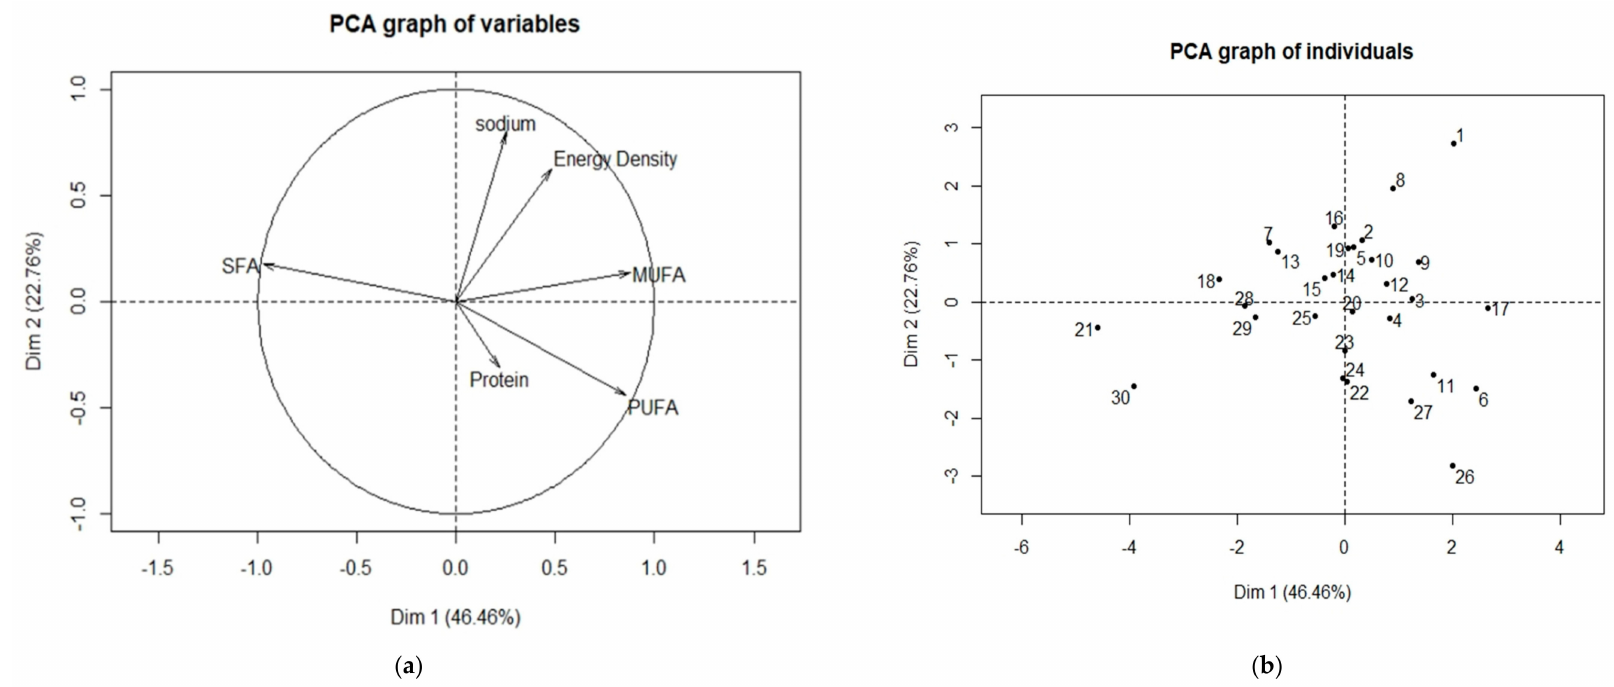
Figure 2. ( a ) PCA plot of di ff erent variables; ( b ) PCA plot of individual sample. (1) Salted Egg Fish Skin; (2) Arrowhead Cracker; (3) Peanut Pu ff ; (4) Egg Crisp; (5) Plait Cookies; (6) Peanut Candy; (7) Cashew Nut Cookies; (8) Seaweed Roll; (9) Prawn Roll; (10) Green Pea Cookies; (11) Peanut Sesame; (12) Almond Cookies; (13) Almond Cashew Chocolate Cookies; (14) Vegetarian Almond Cookies; (15) Oat and Bran Cookies; (16) Salted Egg Yolk Cookies; (17) Almond Delight; (18) Butter Cookies; (19) Sambal Chili Tapioca Crisp; (20) Bitter Nut Cracker with Chili; (21) Mini Love Letter; (22) Chocolate Wafer; (23) Bitter Nut Crackers; (24) Strawberry Wafer; (25) Nyonya Pandan Egg Roll; (26) Peanut Cookies; (27) Kueh Bahulu; (28) Sunflower Pineapple Tart; (29) Nyonya Pineapple Roll; (30) Cake